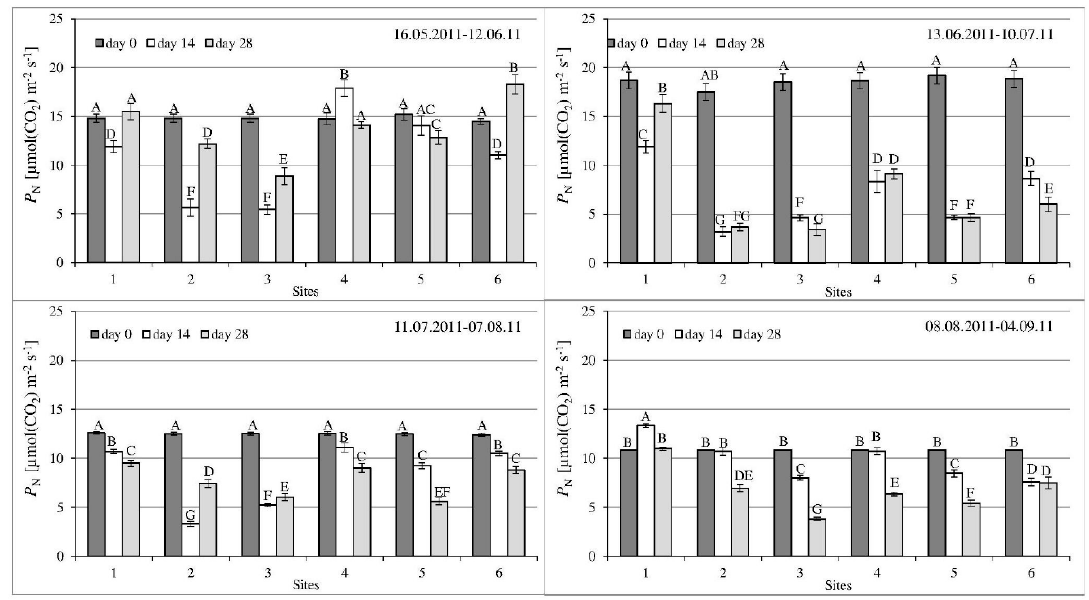
Figure 2. Net photosynthesis rate ( P N ) of L. multiflorum measured at control and exposure sites during four series. Vertical bars represent standard errors; different letters denote significance difference at level α ≤ 0.05 between all treatments within each series.